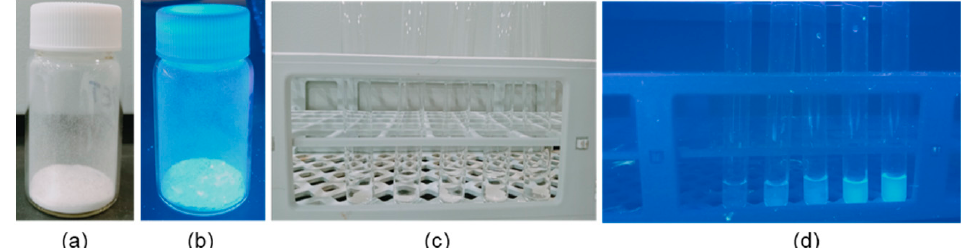
Figure 2. Images of solid aminolysed product (3) under normal ( a ) and UV light ( b ). Aqueous solution of (3) under normal ( c ) and UV-light ( d ). Solutions were prepared by dissolving a different amount (1, 2, 5, 10, 25 mg/mL) of (3) in distilled water.